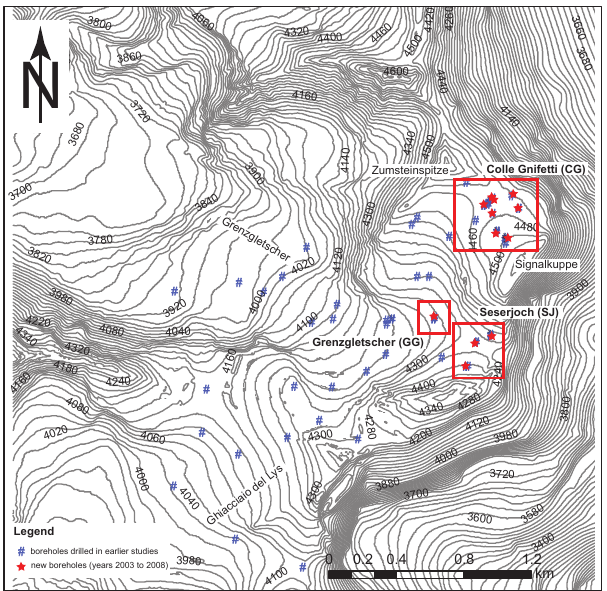
Fig. 2. Location of the borehole sites on Colle